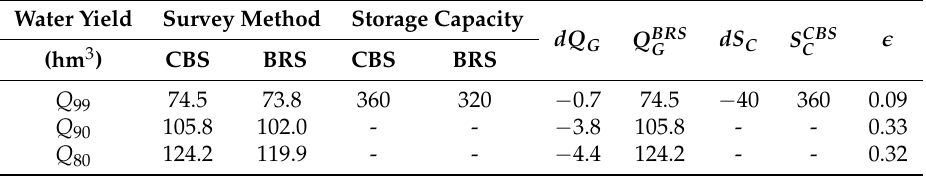
Table 4. Elasticity ( (cid:101) ) for the Pentecoste reservoir as a function of the water-yield reliability; and of the bathymetric methods. Abbreviations: CBS, Conventional bathymetric survey; BRS, Bathymetric survey using remote sensing simplified method; S, storage capacity; Q G , water yield discharge associated with reliability G. For the terms dQ r and dS C , please refer to Equation